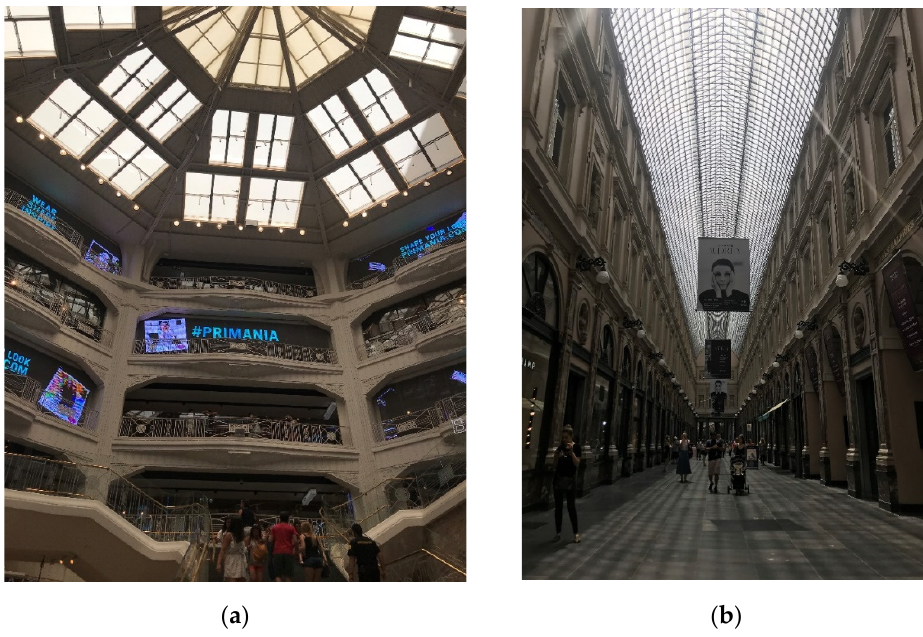
Figure 2. Simple atrium examples: ( a ) a round atrium free of additional internal elements (photograph courtesy of Brzezi ń ska); ( b ) a long rectangular atrium free of additional internal elements (photograph courtesy of Brzezi ń ska).